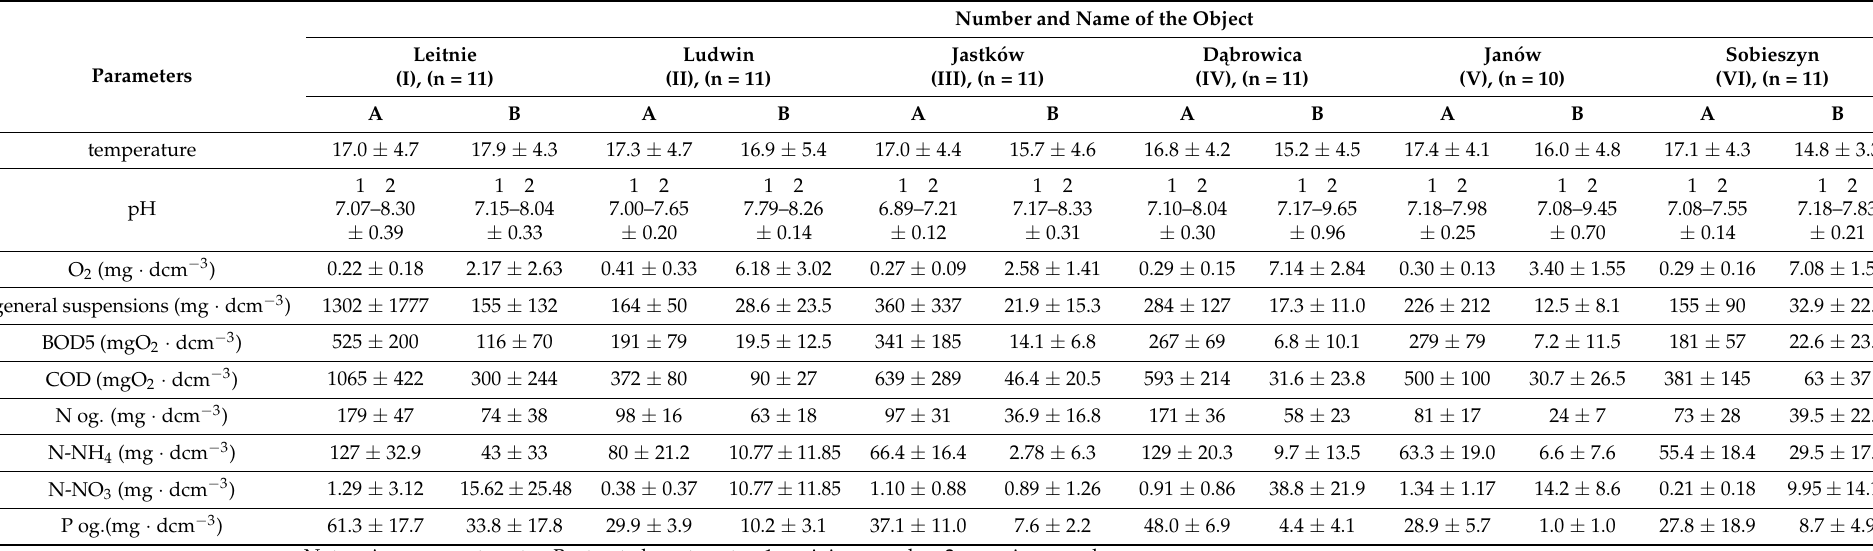
Table 3. Characteristics of the physicochemical properties (mean values) of raw and treated domestic wastewater from small wastewater treatment plants